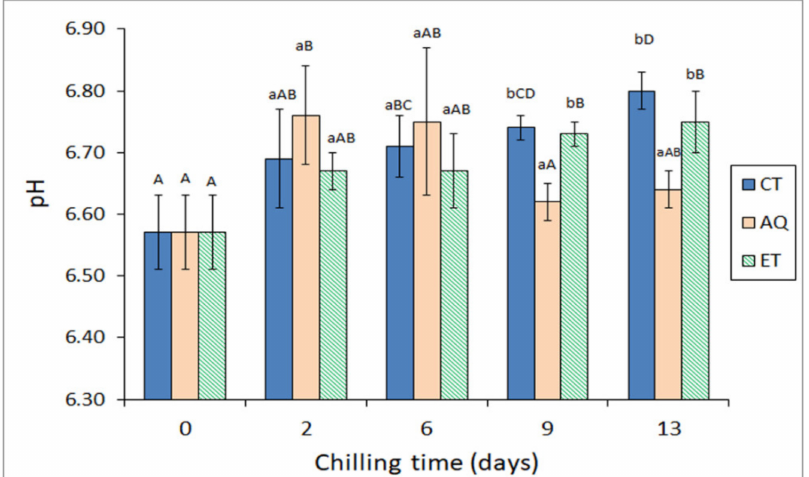
Figure 2. Evolution of pH value * in chilled hake subjected to different icing conditions **. * Average values of three replicates ( n = 3); standard deviations are indicated by bars. For each chilling time, different lowercase letters denote significant ( p < 0.05) differences as a result of icing conditions. For each icing condition, different capital letters denote significant ( p < 0.05) differences as a result of chilling time. ** Icing conditions as expressed in Table